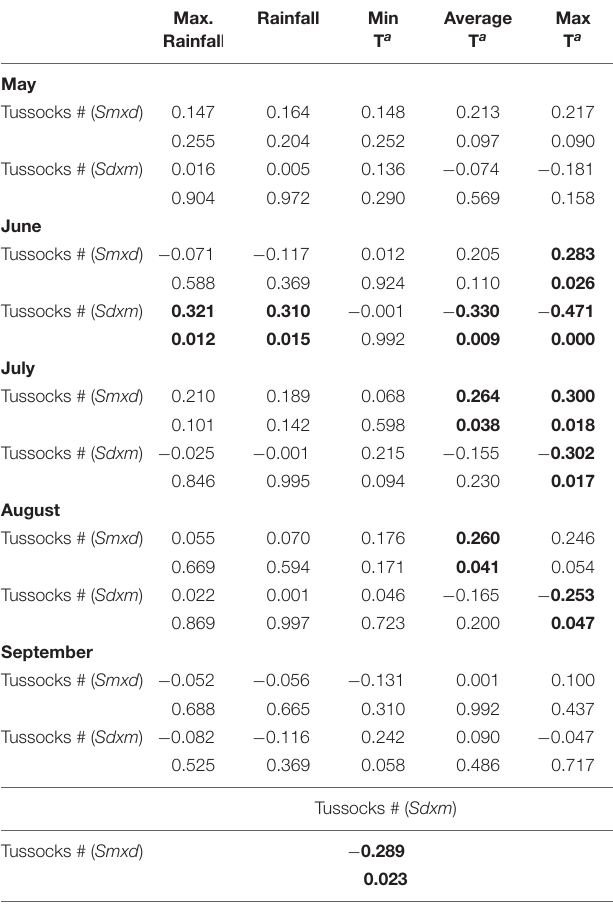
TABLE 1 | Correlations between the number of annually established of tussocks of Spartina hybrids and meteorological conditions. Max. Rainfal